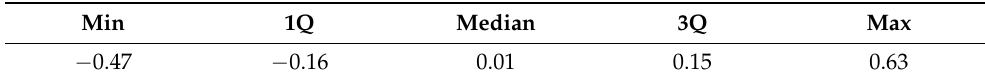
Table 3. Five-point table of the linear model’s